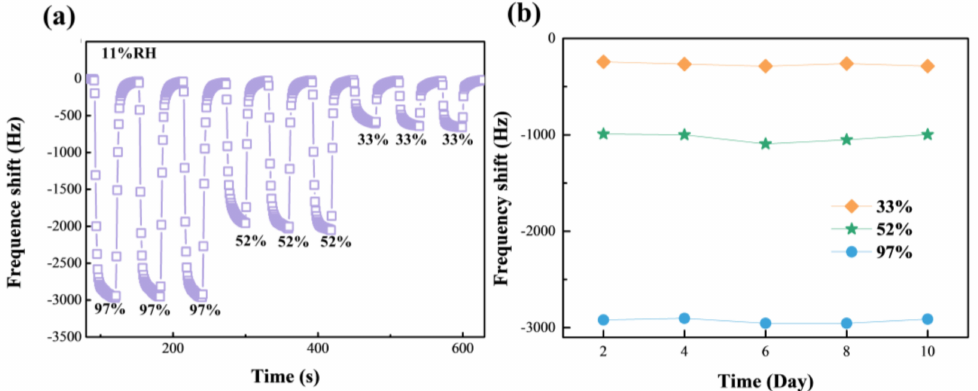
Figure 8. The repeatability ( a ) and stability ( b ) test of the HGO&GO&Mg 2+ -based QCM humidity